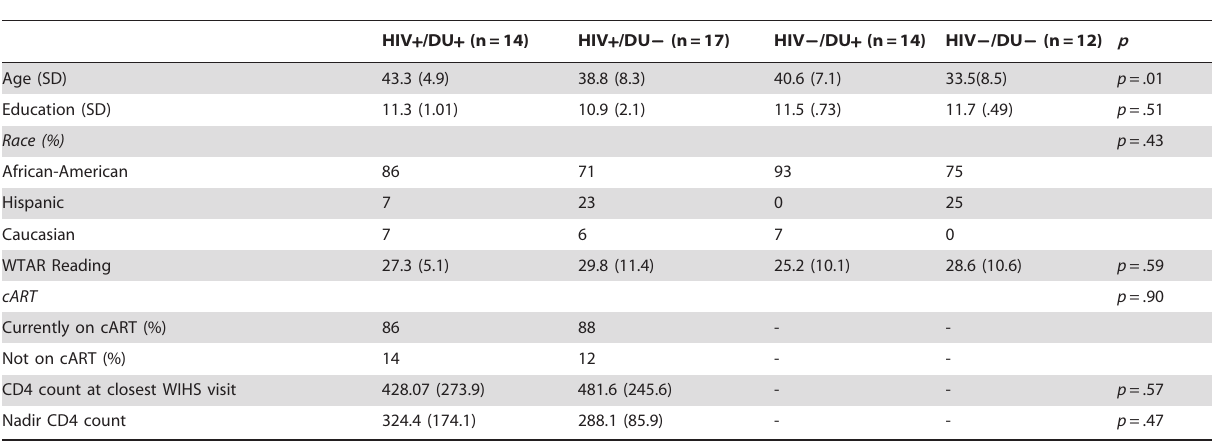
Table 1. Demographic and HIV disease characteristics of participants.